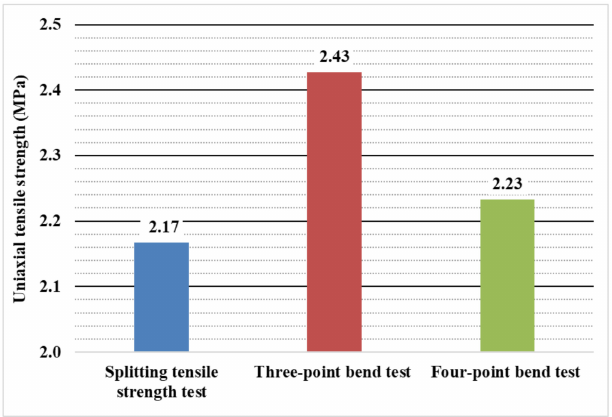
Figure 7. Uniaxial tensile strength for individual types of tests.